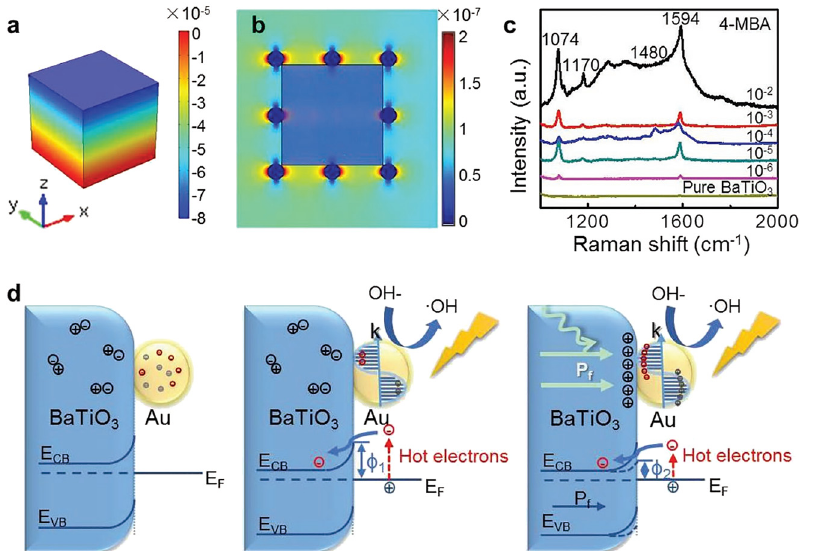
Figure 7: (a) 3D Simulation of the piezoelectric effect in BaTiO 3 nanocube. (b) Electric fi eld distribution on gold nanoparticles on BaTiO 3 NC showing the enhancement. (c) SERS of 4-mercaptobenzoic acid on the Au-BaTiO 3 complex. (d) Mechanism of the piezotronics-enhanced photocatalysis